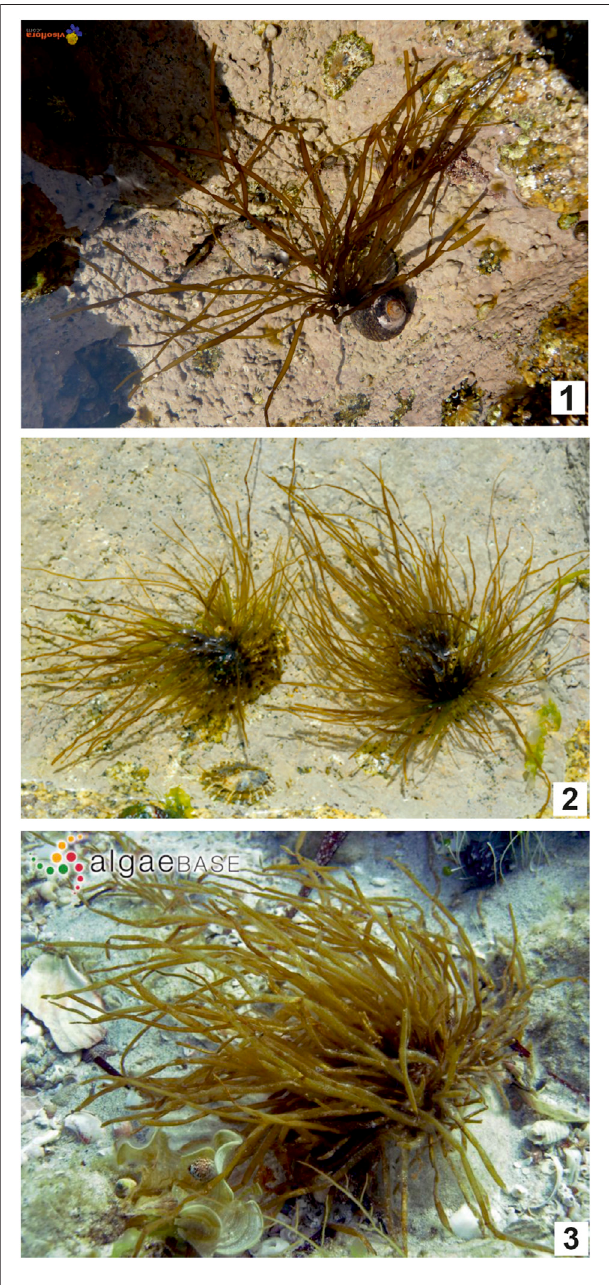
FIGURE 4 | Photographs of modern brown algae ( Phaeophyta ) Scytosiphon lomentaria (1 – 4). Source – 1 . https://www.viso fl ora.com/ photos-nature/photo-scytosiphon-lomentaria-1.html; 2 . http://www. seaweed.ie/descriptions/Scytosiphon_lomentaria.php; 3. https://